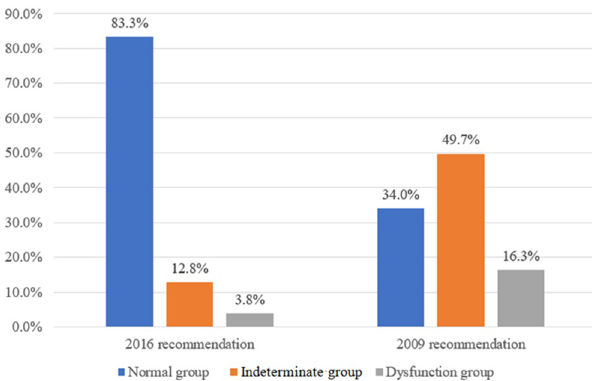
Fig 1. Prevalence of diastolic dysfunction according to each classification in patients who underwent living-donor liver